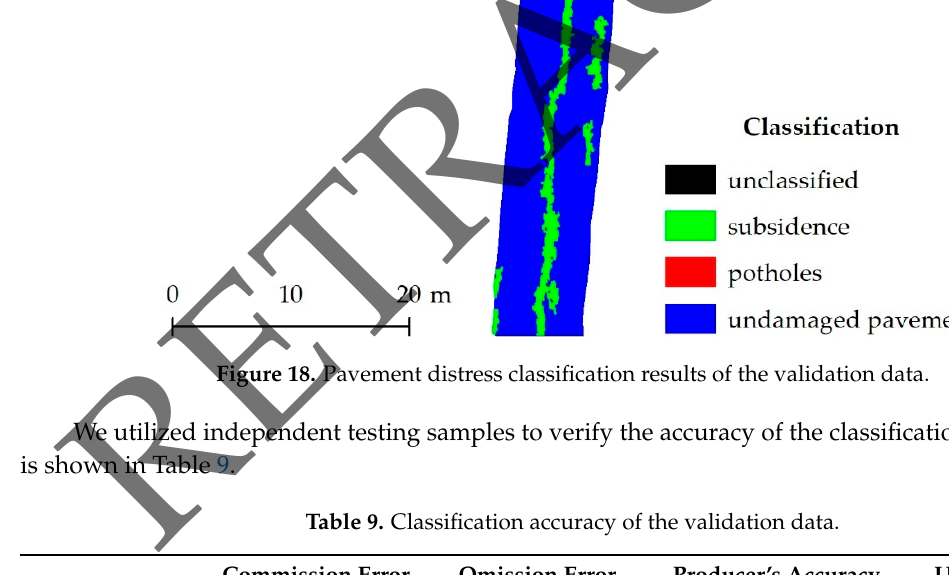
Table 9. Classification accuracy of the validation data.